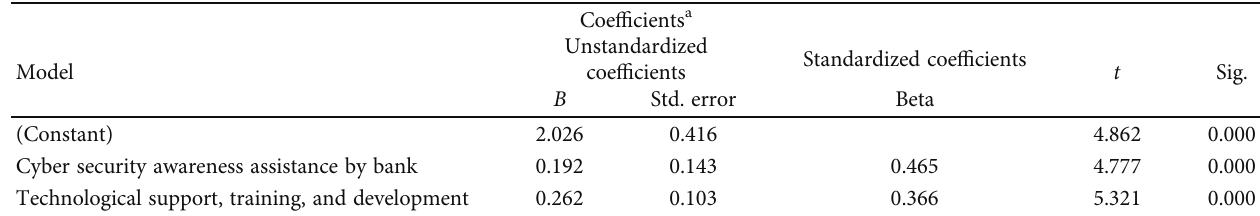
Table 12: Coe ffi cient regression models 1 and